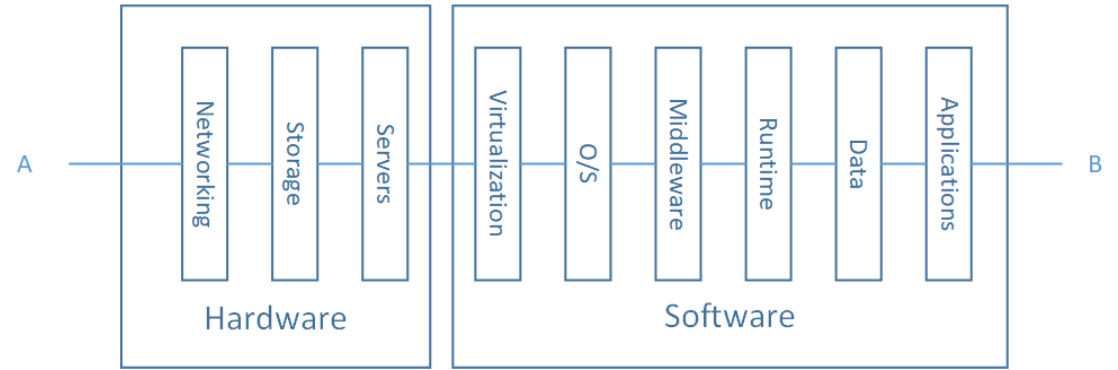
Figure 11. Middleware layer RBD model.